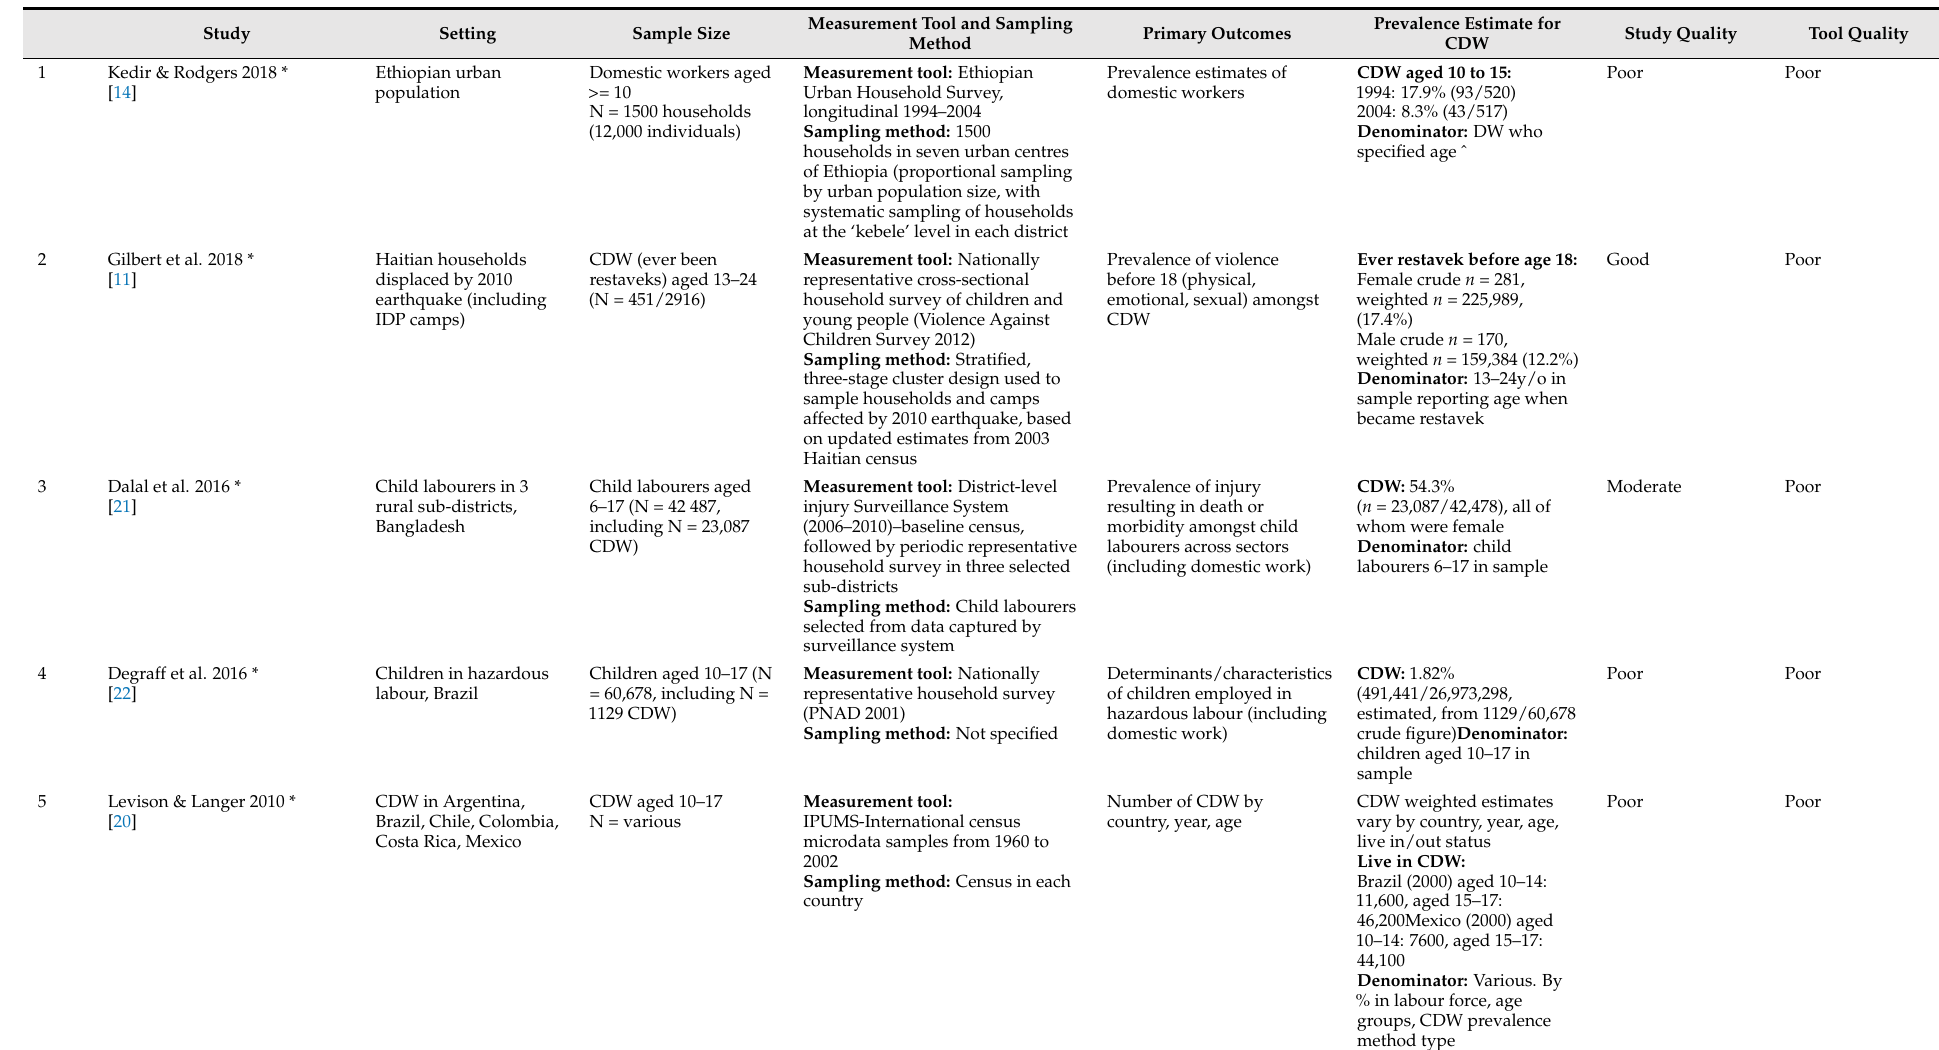
Table 1. CDW cross-sectional prevalence study characteristics ( n =